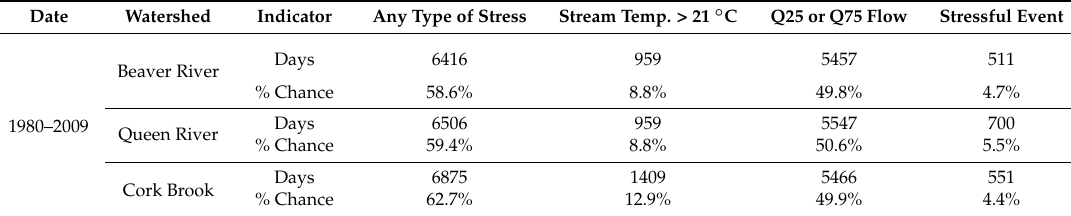
Table 6. Stressful event analysis of SWAT simulation for the three study